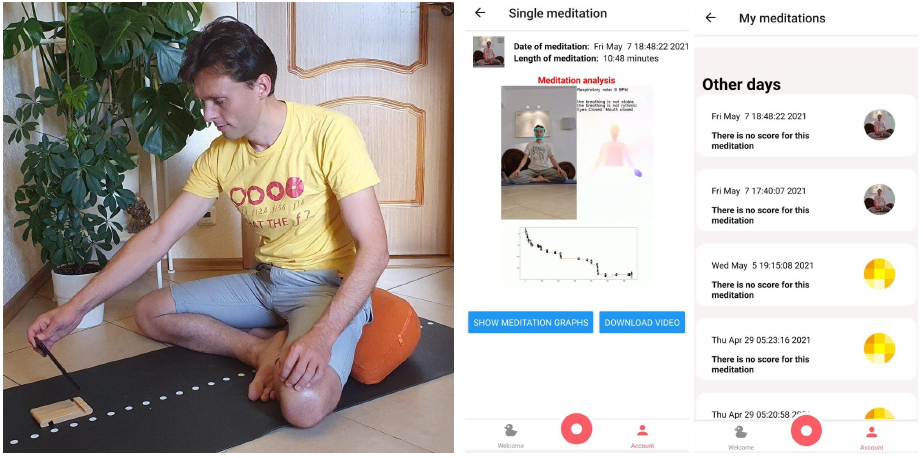
Figure 18. The meditation application